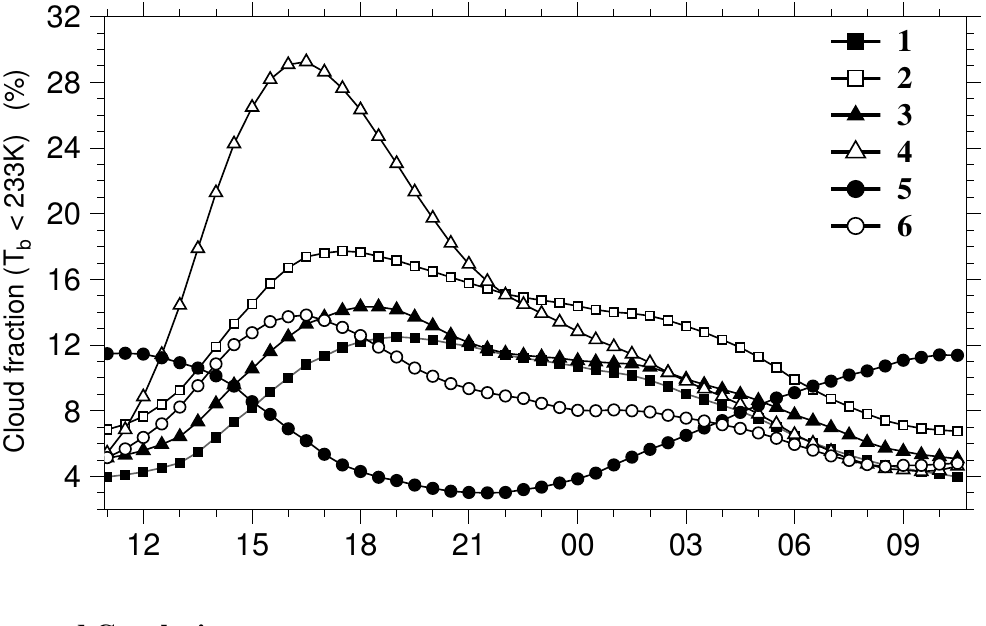
Figure 9. Regional variability of the diurnal cycle of average half-hourly cloud fraction computed for a threshold of 233 K over the six regions indicated in Figure 1. The symbols correspond to the domain on which statistics are computed. The X axis denotes the